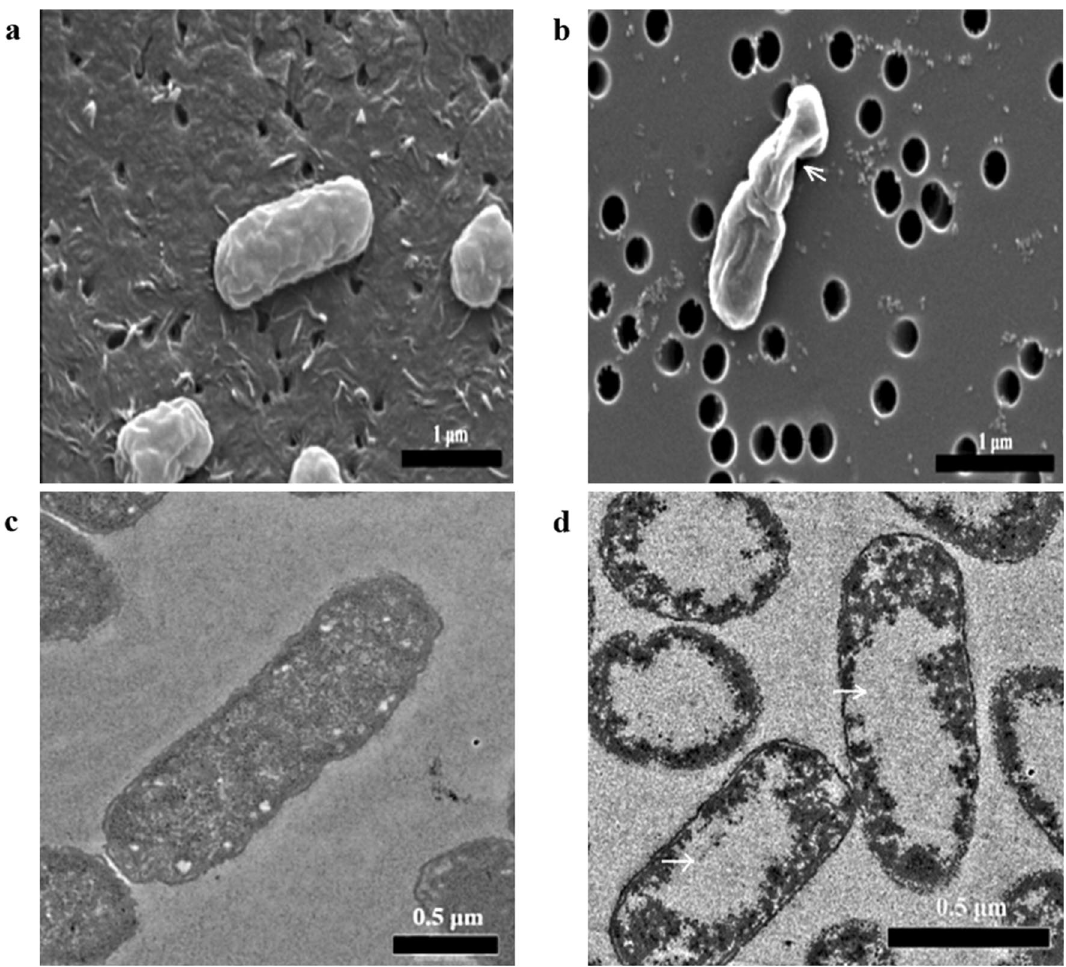
Figure 4. Scanning electron micrographs of KPC-KP. ( a ) Untreated; ( b ) CN-treated KPC-KP cells (14.42 mg/ mL). The treated KPC-KP cells with corrugated cell membrane was indicated by the white arrow. Scale bar in scanning electron micrographs represents 1 μm. Tranmission electron micrographs of KPC-KP. ( c ) Untreated; ( d ) CN-treated KPC-KP cells (14.42 mg/mL). The treated cells with cytoplasmic clear zones and lacked of staining zones were indicated by the white arrows. Scale bar in scanning electron micrographs represents 0.5